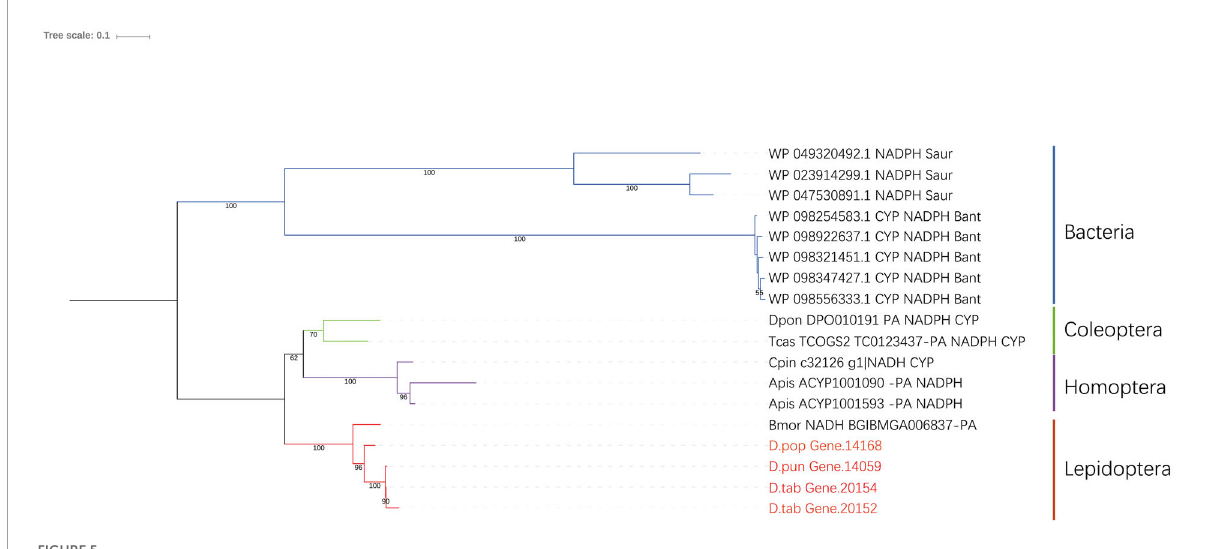
FIGURE5 Phylogenic analysis of CPR. Eight insect species and two bacteria species were included in the picture, and Gastropacha populifolia , Dendrolimus punctatus, and Dendrolimus tabulaeformis are marked in